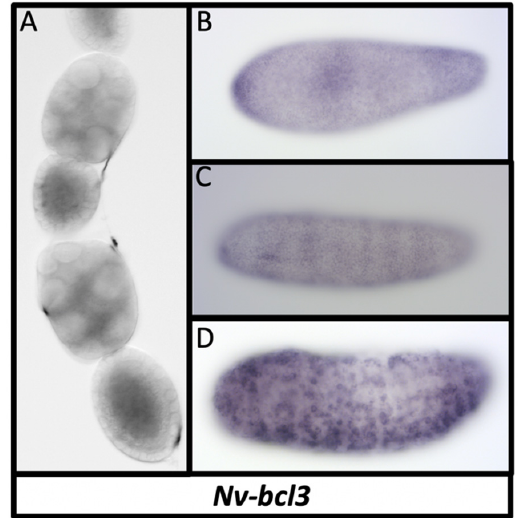
Figure 8. Expression of Nv-bcl3 in ovaries and embryos. ( A ) Nv-bcl3 is ubiquitously expressed in oocytes, lacking in the follicle cells, and is restricted to the posterior of the nurse cells (early to mid oogenesis shown). ( B ) In the early blastoderm, Nv-bcl3 is expressed ubiquitously with variation in intensity along the AP axis. ( C ) Expression evolves into broad stripes with fuzzy borders into late blastoderm stages. ( D ) After gastrulation, Nv-bcl3 is expressed in scattered cells of unknown